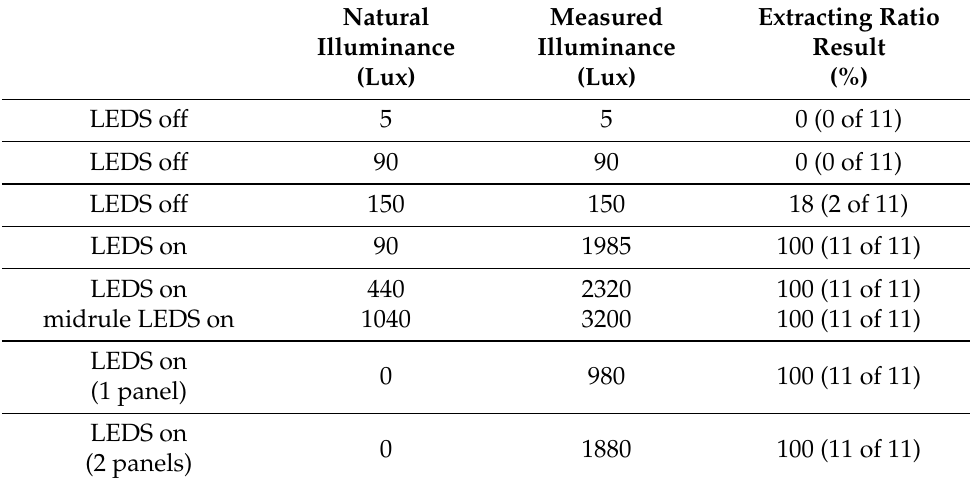
Table 1. Extracting result ratio for different illumination